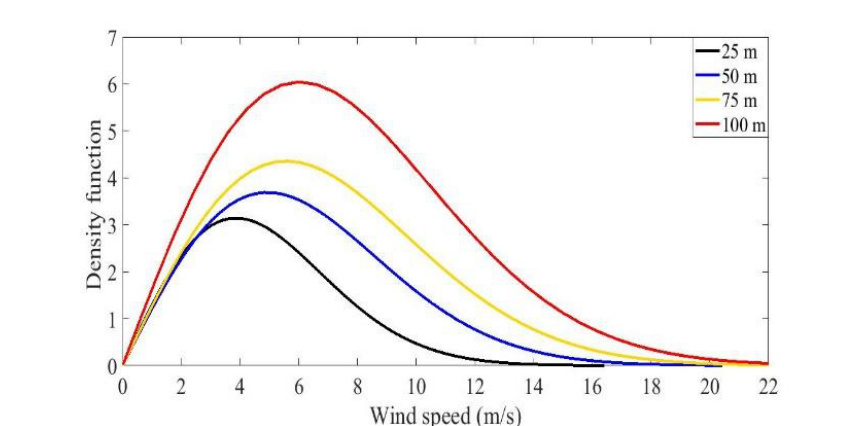
Figure 4. Wind speed distribution function at different altitudes